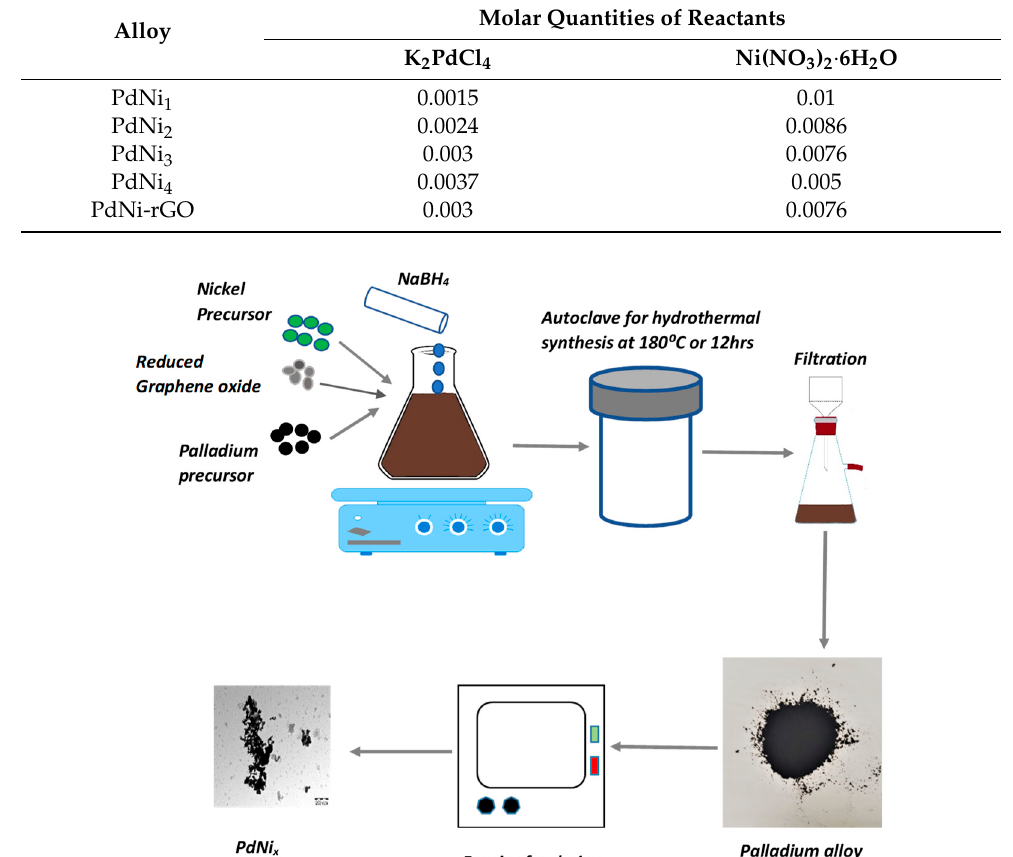
Table 1. Molar quantities of reactants utilized for the fabrication of PdNi x alloys.